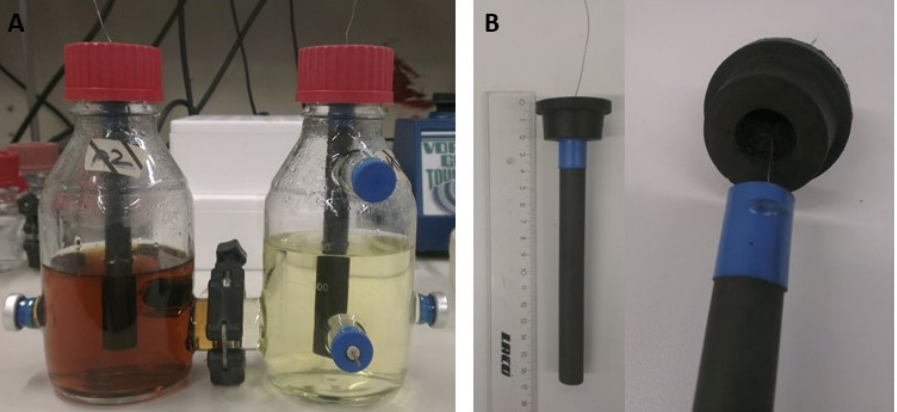
Figure 1. Bioelectrochemical setup with ( A ) custom-made, gas-tight 500 mL H-cell with Balch tube connections and ( B ) electrode integration via a platinum wire. Reprinted with permission from Ref. [11]. 2019,